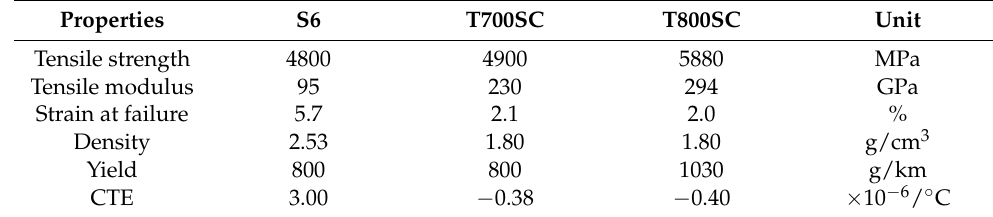
Table 1. Properties of raw materials.